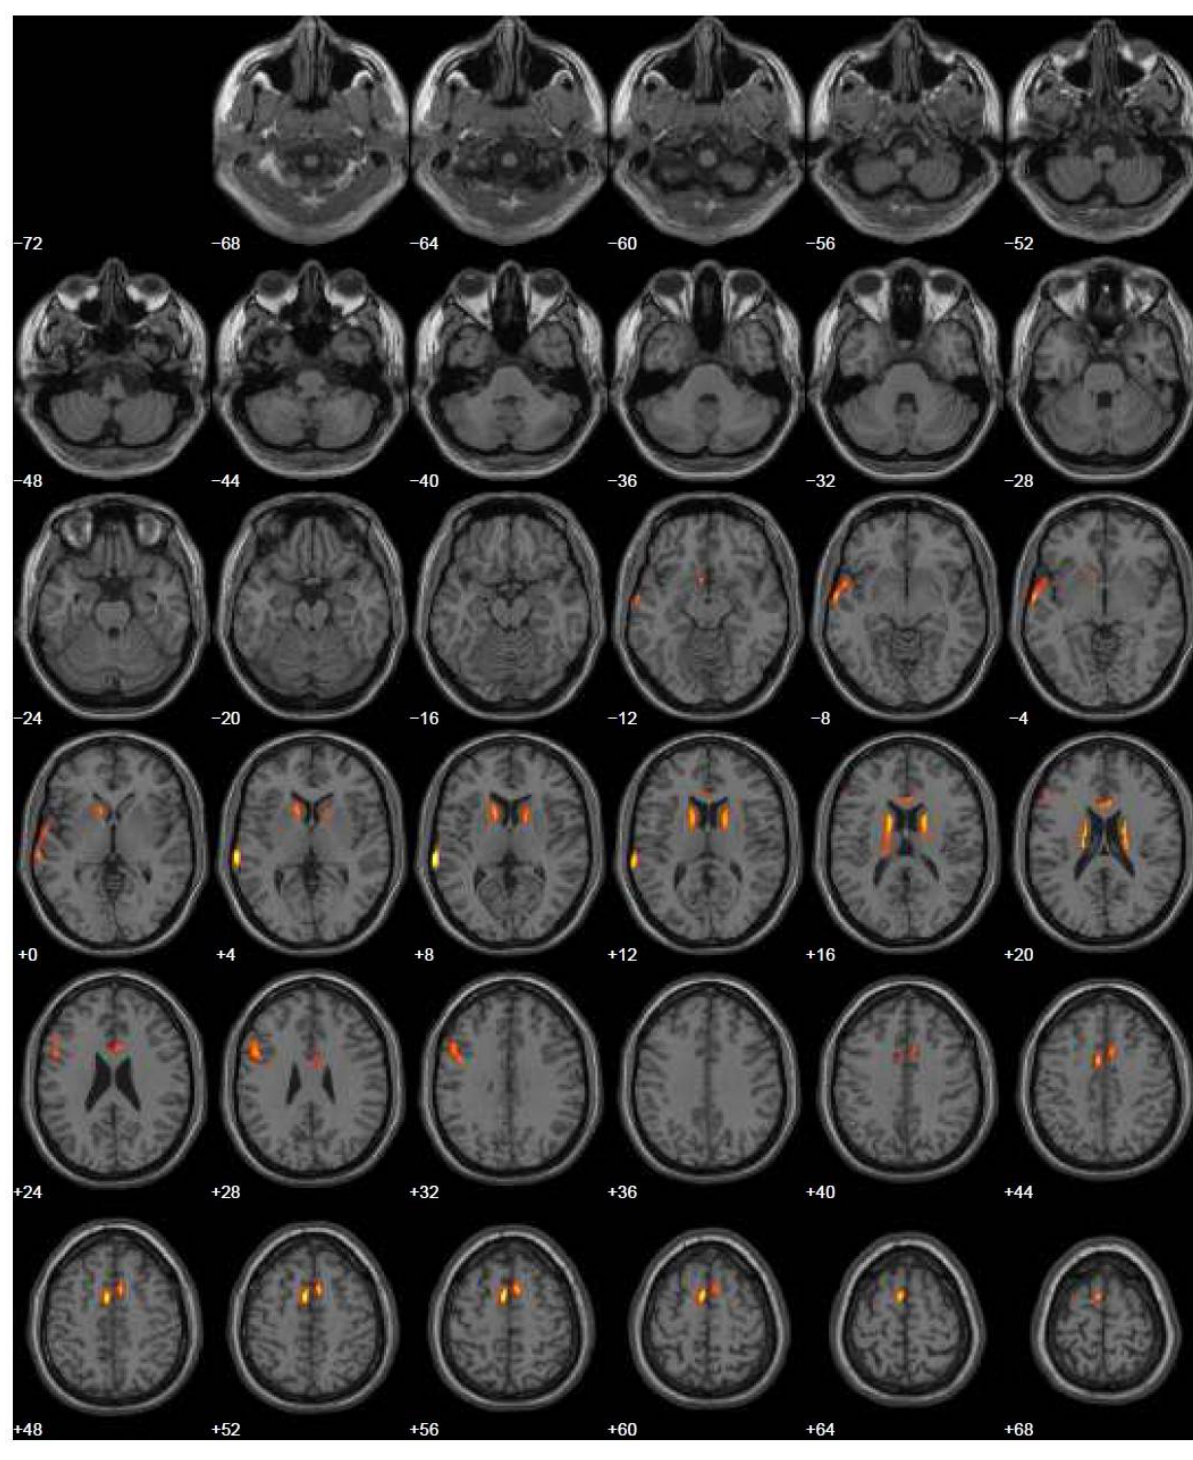
Figure 3. Brain PET with 18F-FDG three years after symptom onset (2015). SPM map of significant hypometabolic areas ( p = 0.05) overlaid on the structural MR template included in SPM5. Hypometabolism was detected in left middle and superior temporal gyrus (BA 42, BA 21, and BA 38), superior frontal gyrus bilaterally, left inferior frontal gyrus (BA 9 and BA 46), anterior cingulate bilaterally, and subcortical structures bilaterally.